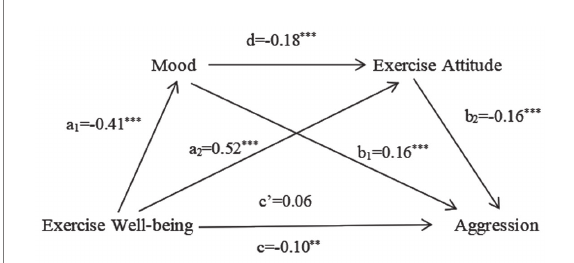
FIGURE 2 Chain mediating model test of exercise well-being. a1 predicts the regression coefficient of mood for exercise distress; a2 and d jointly predict the partial regression coefficient of exercise distress and mood; c’, b1 and b2 jointly predict the partial regression coefficient of aggression for exercise distress, mood and exercise attitude; c indicates the regression coefficient of exercise distress to aggression without mediating variables. * p <0.05, ** p <0.01, and *** p